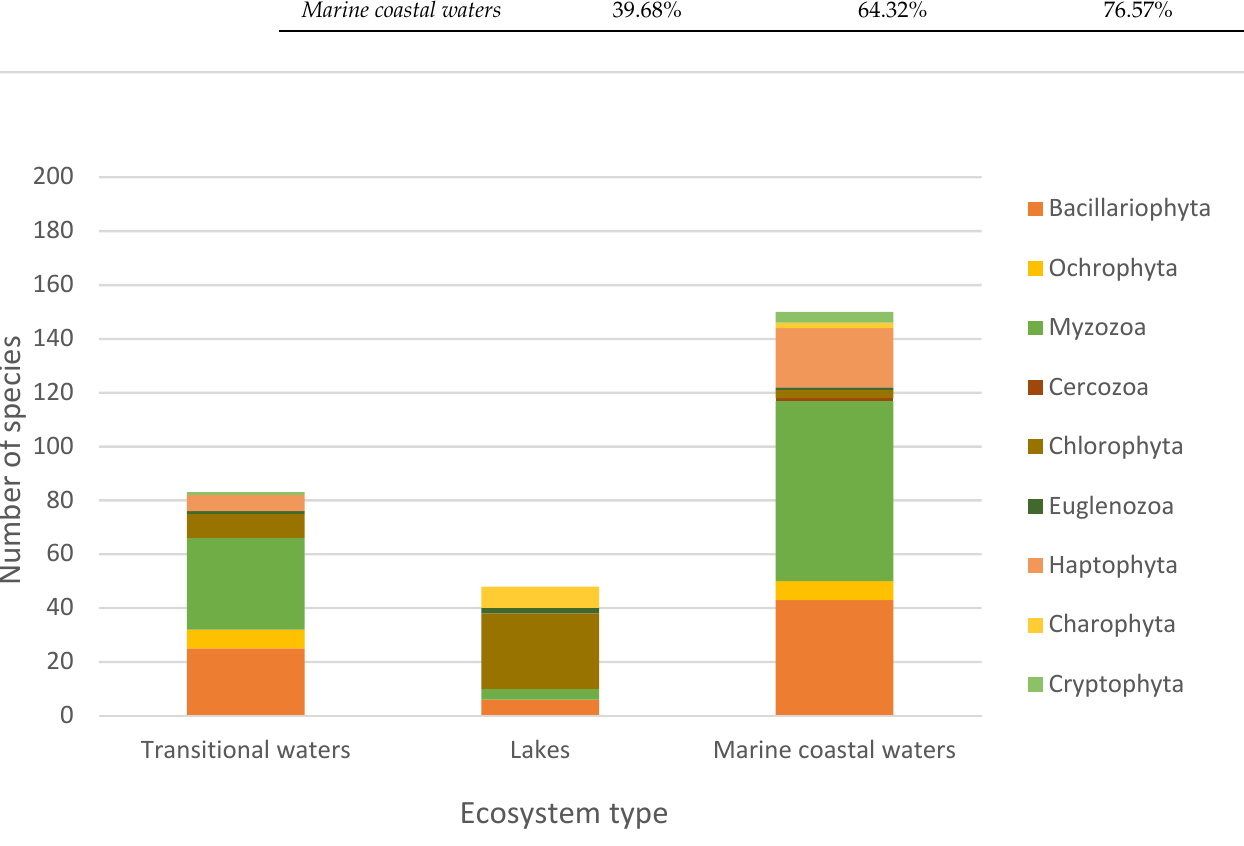
Figure 1. Number of phytoplankton species without an 18S barcode for the different phyla in transitional waters, lakes, and marine coastal waters.